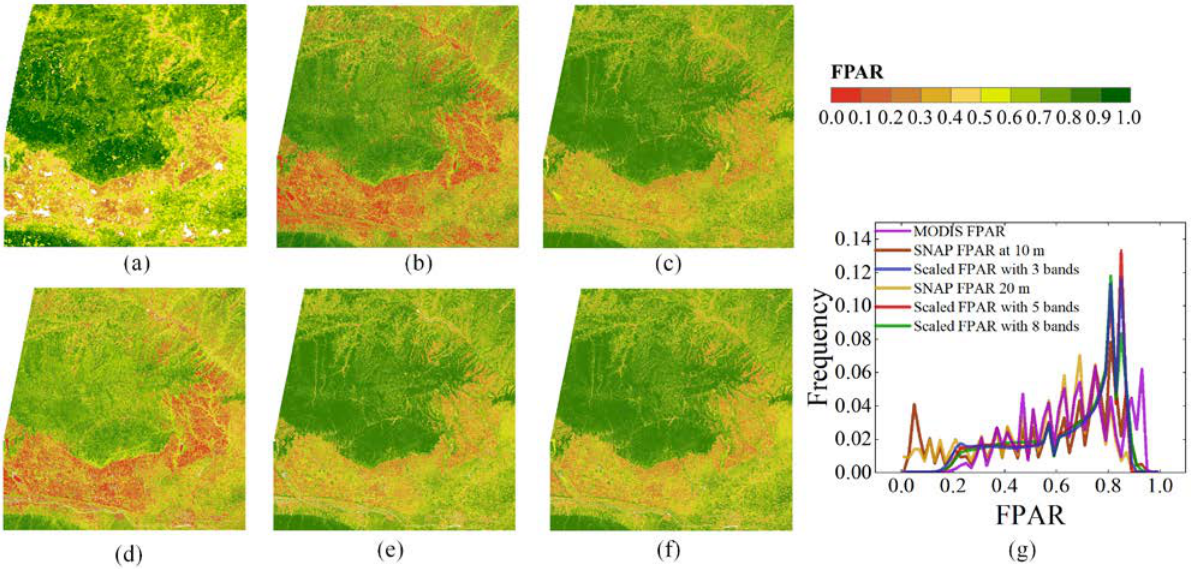
Figure 4. Comparison of MODIS FPAR and Sentinel FPAR images retrieved by SNAP and the scaling-based method in the study area on 1 August 2021. ( a ) MODIS FPAR. ( b ) SNAP FPAR at 10 m. ( c ) Scaled FPAR with three bands. ( d ) SNAP FPAR at 20 m. ( e ) Scaled FPAR with five bands. ( f ) Scaled FPAR with eight bands. ( g ) Histograms of the results.